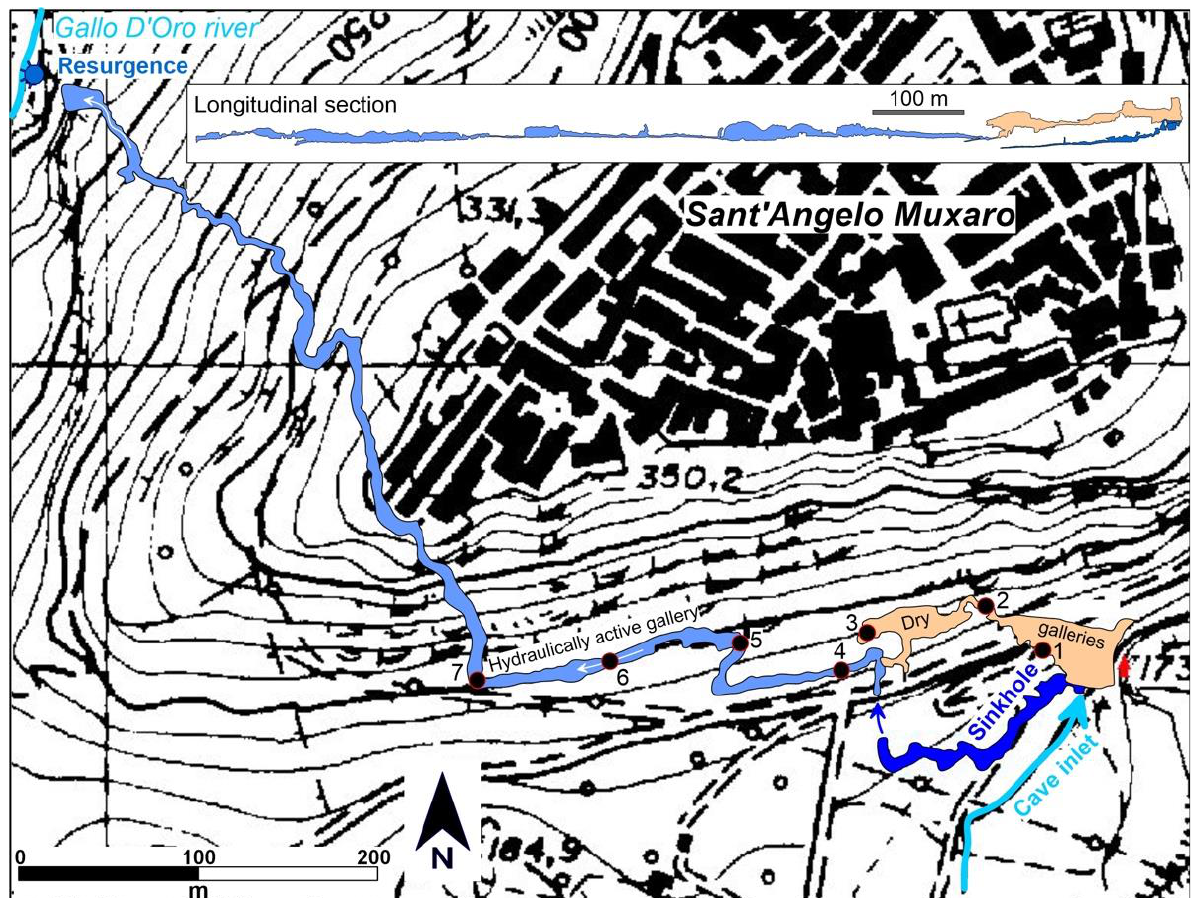
Figure 4. Surface projection of the area occupied by the Sant’Angelo cave and its longitudinal section, with location of the points of measure (spot); different colors indicate the hydraulic regime of different volumes of the cave.